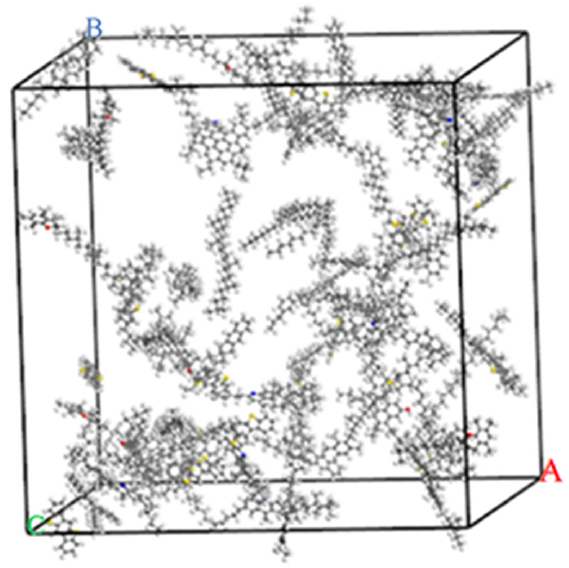
Figure 2. Matrix asphalt model.